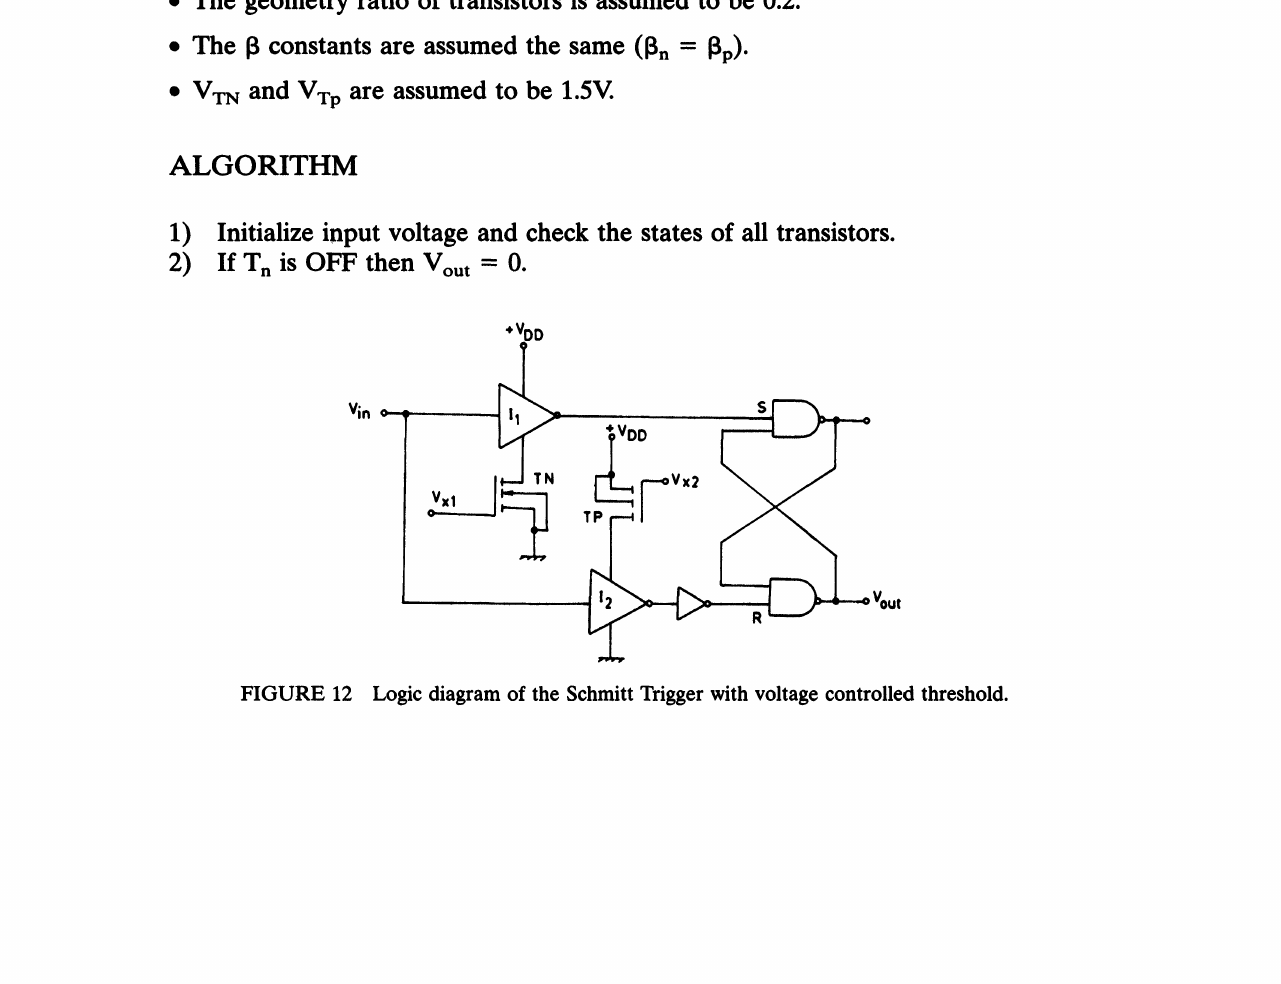
FIGURE 12 Logic diagram of the Schmitt Trigger with voltage controlled